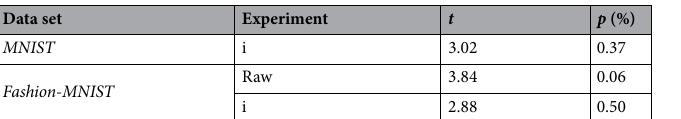
Table 1. Endangered by alpha value inflation accuracy t-test for ‘ small world 1194 is best’. i—structure implantation.